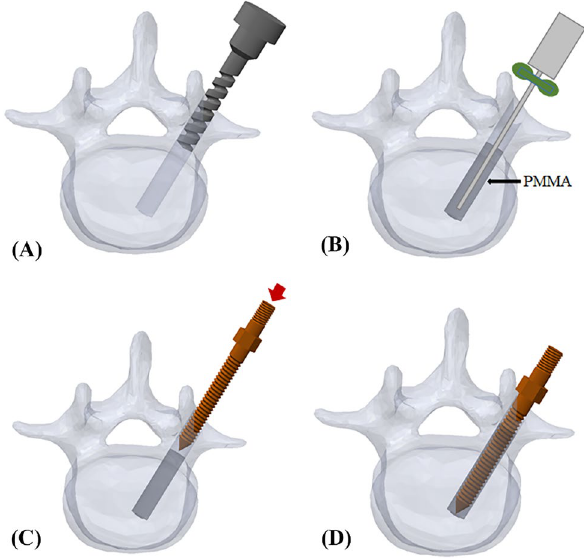
Figure 6. Schematic illustrations of the traditional group. The 48 mm depth enlarged screw tract was created by 5.5 mm twist metric drill bit ( A ). A total of 0.8 ml of PMMA (with consistency similar to that of toothpaste) was